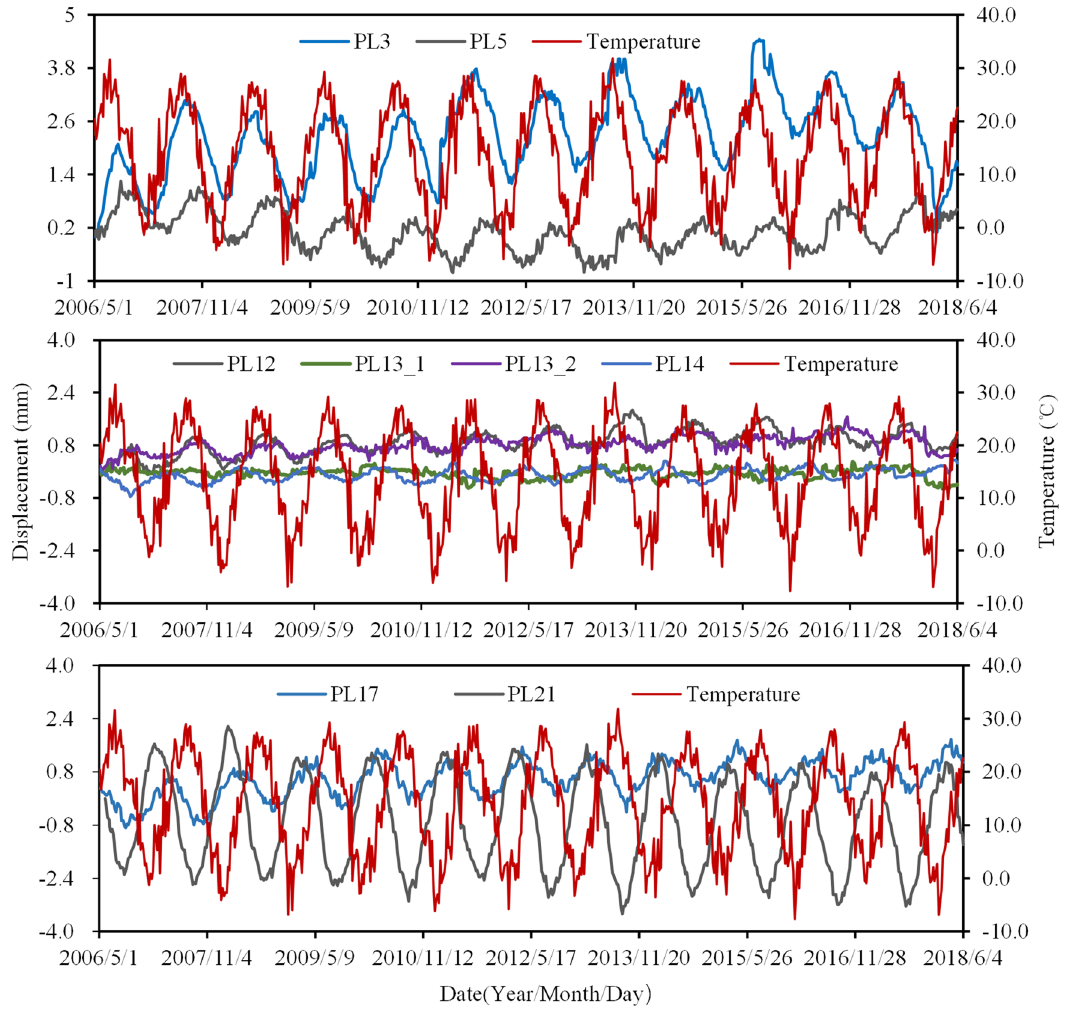
Figure 11. Tangential displacements of the No. 3,13 and 21